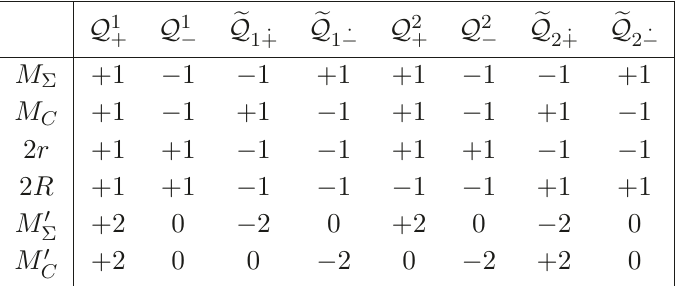
Table 2 . The spins, R-charges and twisted spins of the Poincar´e supercharges. Those of the conformal supercharges are opposite of their hermitian